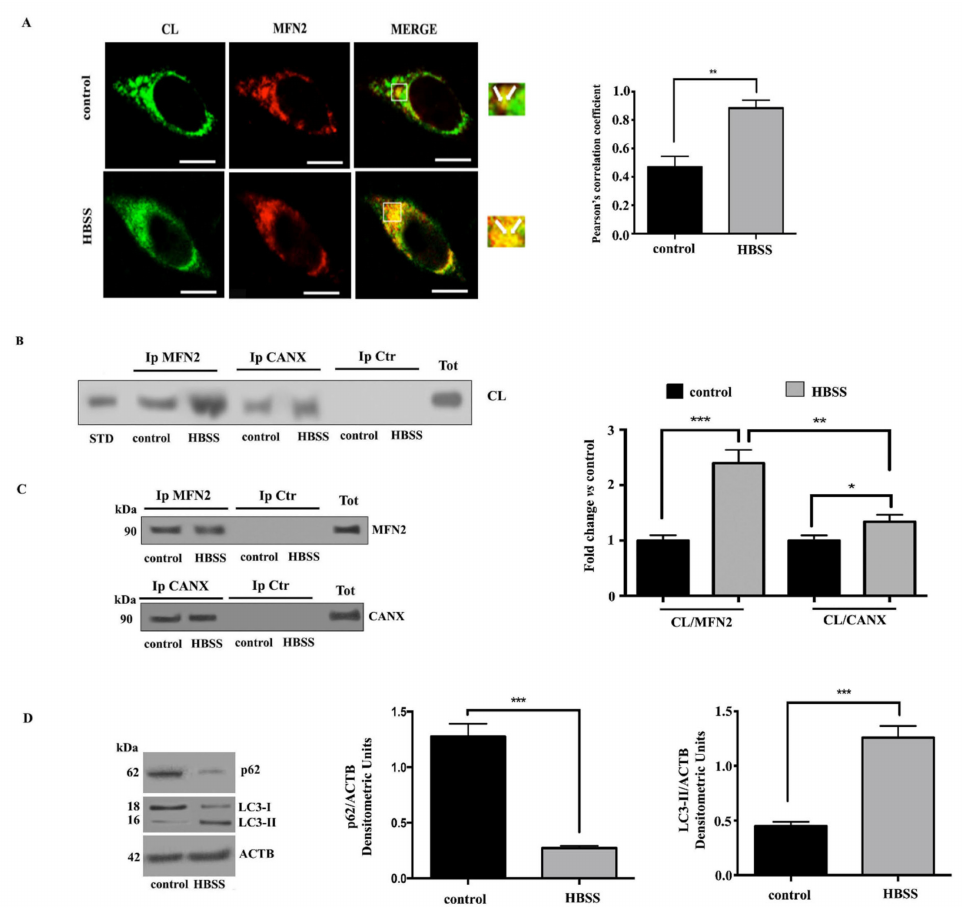
Figure 4. CL interaction with MFN2 and CANX during autophagy induction in neuronal cells. ( A ) SKNB-E-2 cells, untreated or treated with HBSS for 1 h, after fixation with 4% paraformaldehyde in PBS for 30 min at room temperature and then permeabilization by 0.5% Triton X-100 in PBS for 5 min at room temperature, were double stained with human anti-CL and rabbit anti-MFN2 primary antibodies for 1 h, followed by addition of Texas Red-conjugated anti-rabbit IgG and FITC-conjugated anti-human IgG (Sigma-Aldrich) for an additional 45 min at 37 ◦ C. The images were acquired with Olympus FV1000 spectral confocal laser scanning microscope. Pearson’s correlation coefficient was calculated. ** p ≤ 0.01. Scale bar, 5 µ m. ( B ) SKNB- E-2 cells, untreated or treated with HBSS for 1 h, were lysed in lysis buffer, followed by immunoprecipitation with rabbit anti-MFN2 or rabbit anti-CANX PAb. A rabbit IgG isotypic control (IpCtr) was employed. The immunoprecipitates were subjected to phospholipid extraction and analyzed by HPTLC immunostaining for the presence of CL. A positive control was obtained using pure standard CL (STD, Sigma-Aldrich). ( C ) The immunoprecipitates were checked by Western blot analysis, using mouse anti-MFN2 MAb or mouse anti-CANX MAb. A representative experiment among 3 is shown. Bar graph on the right shows densitometric analysis. Results represent the mean ± SD from 3 independent experiments. * p ≤ 0.05, ** p ≤ 0.005, *** p ≤ 0.001 HBSS vs. control cells. ( D ) Autophagy was checked by Western blot analysis, using rabbit anti-LC3 PAb or rabbit anti-p62/SQSTM1 PAb. Loading control was evaluated using anti-ACTB MAb. A representative experiment among 3 is shown. Bar graph on the right shows densitometric analysis. Results represent the mean ± SD from 3 independent experiments. *** p ≤ 0.001, HBSS vs. control